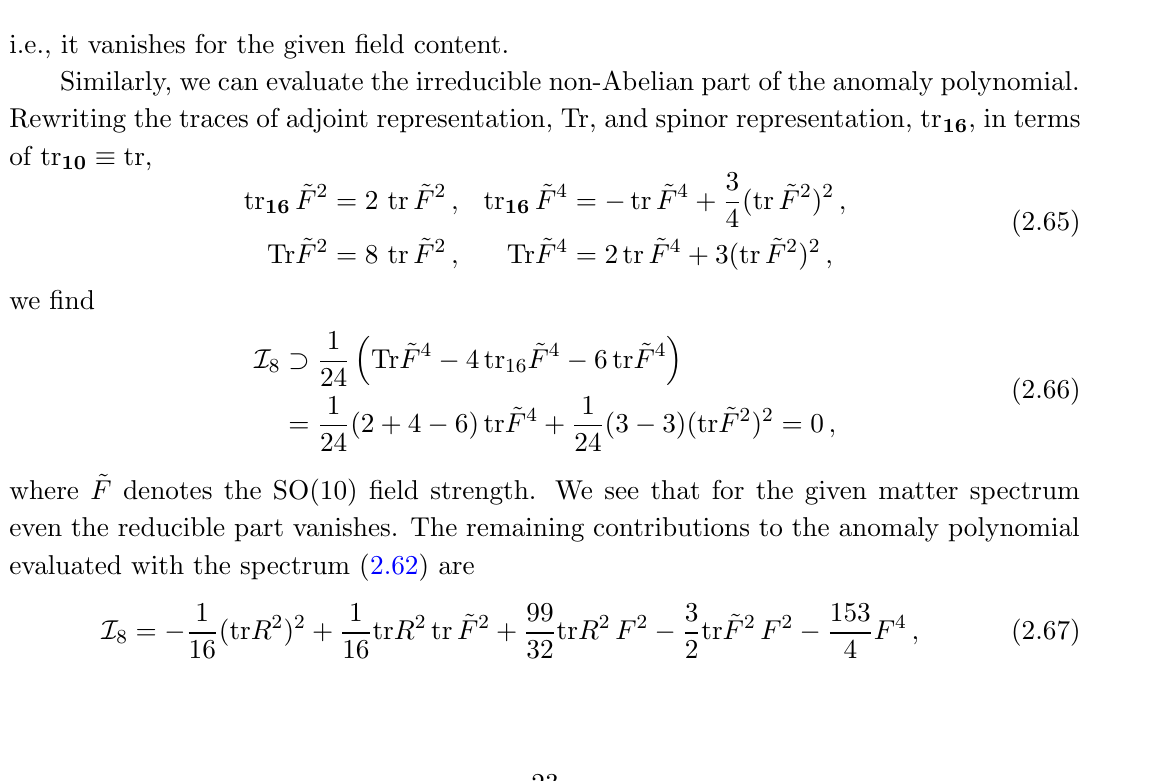
Figure 14 . In a complex three-dimensional space, SO(10) matter is represented by curves in the plane , the locus of the SO(10) gauge (cid:12)elds. The curves of the matter (cid:12)elds 16 Z 16 10 (cid:0) 1 = 4 ( z 0 = d 7 = 0) and (cid:0) 1 = 2 ( z 0 = d 1 d 7 (cid:0) d 3 d 5 = 0) intersect at the codimension-three E 7 singularity z 0 = d 5 = d 7 = d 1 d 7 d 3 d 5 = (cid:0)